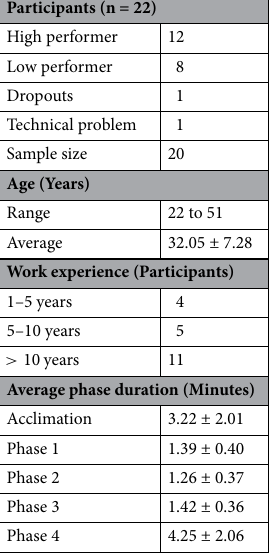
Table 1. Basic demographic information on the